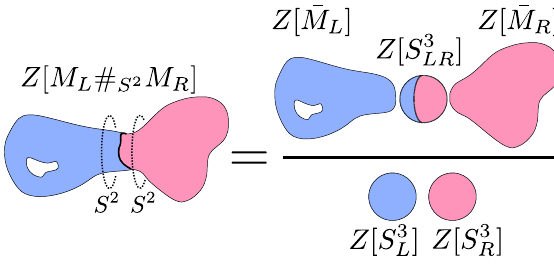
2 interface. We can take surgery cuts just to Figure 8 . Manifolds M L and M R joined along an S the left and right of the interface; the price we pay is that we have to independently evaluate the path integral on S 3 with an S 2 interface (here denoted Z [ S 3 ]). LR